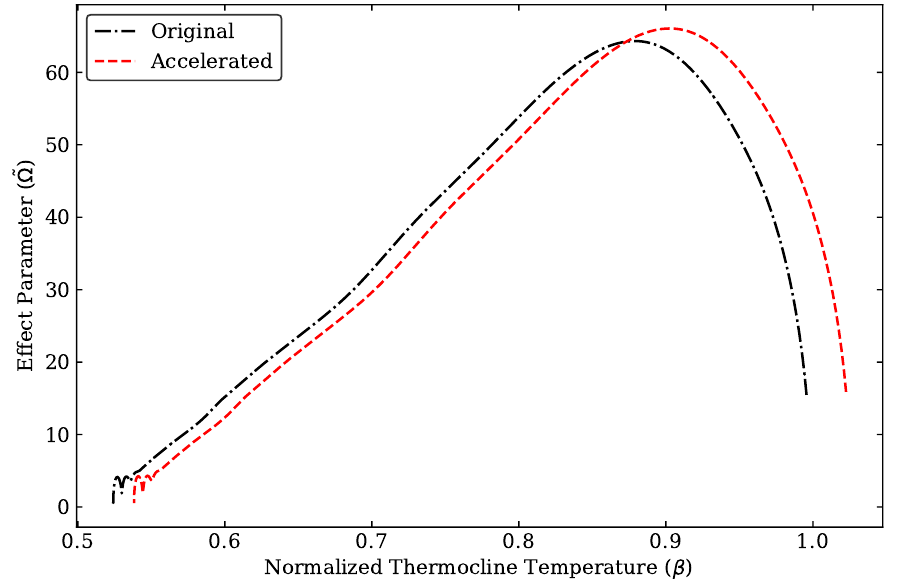
Figure 22. Scaled process curves of discharging mode at the outlet